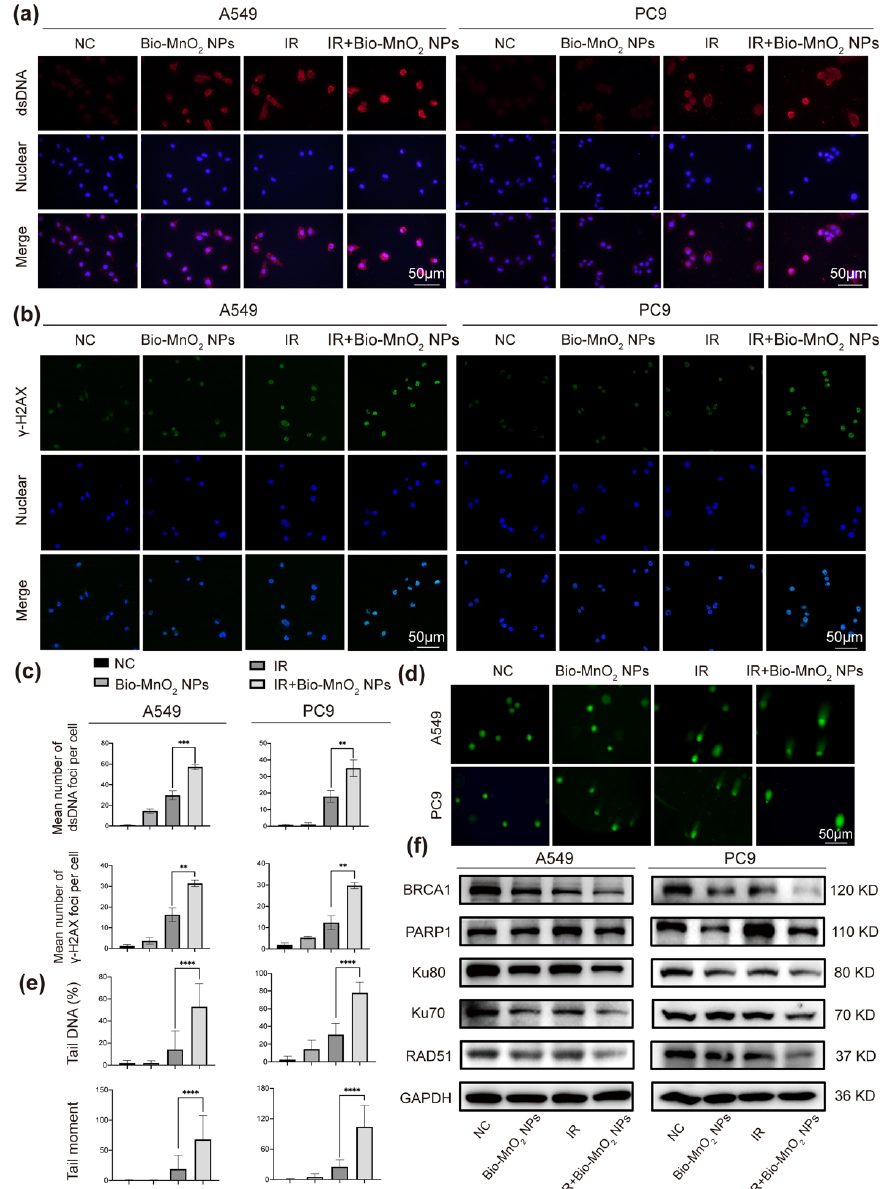
Figure 4. Bio-MnO 2 NPs plus radiation increased DNA damage in NSCLC cells. ( a ) Representative images of double-stranded DNA (dsDNA) immunofluorescent staining (red) after different treatments. Scale bar, 50 μm. ( b ) Representative images of γ -H2AX immunofluorescence (green) after different treatments. Scale bar, 50 μm. ( c ) Statistical graphs of dsDNA and γ -H2AX immunofluorescence. ( d ) Representative images of comet assay after different treatments in NSCLC cells. ( e ) Statistical graphs of comet assay. ( f ) Immunoblotting of DNA damage and repair related proteins. **, p < 0.01; ***, p < 0.001. ****, p < 0.0001.